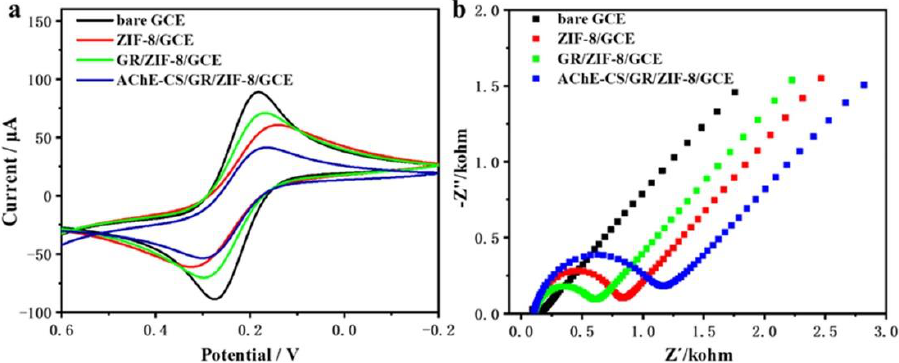
Figure 3. CV curves ( a ) and Nyquist diagrams ( b ) of different modified electrodes in 5 mM Fe(CN) 6 3−/4− (1:1) test solution containing 0.1 M KCl.